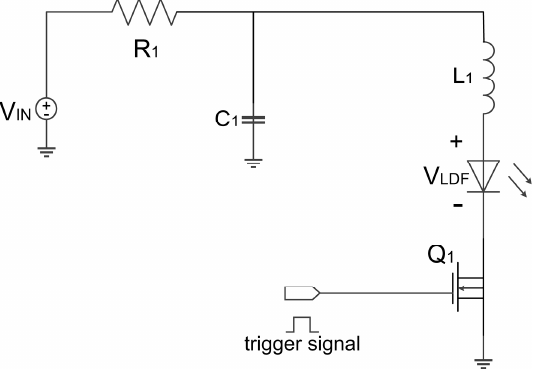
Figure 5. Circuit diagram of the capacitive discharge − type driver.